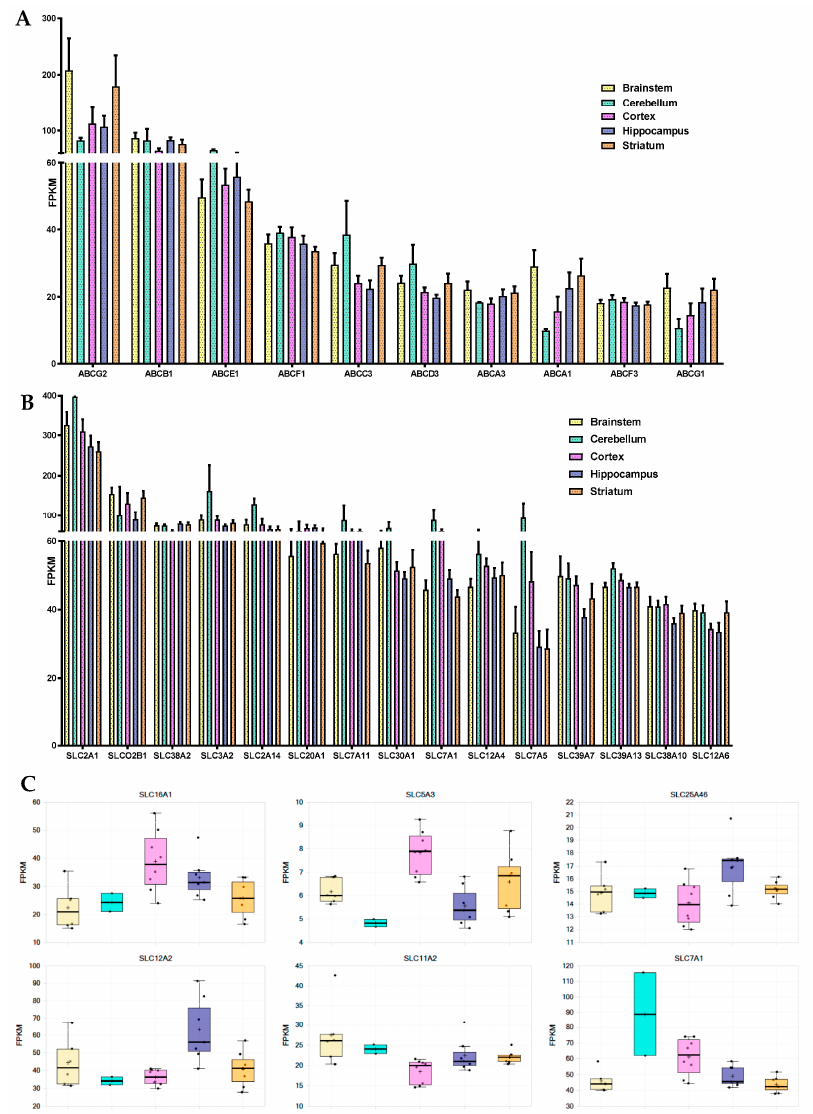
Figure 5. Differences in the mRNA levels of ABC and SLC transporters in the brain endothelium from brainstem, cerebellum, cortex, hippocampus and striatum. ( A ) Representation of the 10 ABC transporters with highest transcript levels in BECs from across the 5 studies brain regions. Expression levels are represented as average FPKM ± SEM. ( B ) Representation of the 15 SLC transporters (typically at plasmatic membrane, excludes SLC25A family, mitochondrial transporters) with highest transcript levels in BECs from across the 5 studies brain regions. Expression levels are represented as average FPKM ± SEM. ( C ) Representation of the 6 SLC transporters for which there is a differential expression ( p < 0.05) in BECs cultivated from a given brain structure in comparison to another brain region.